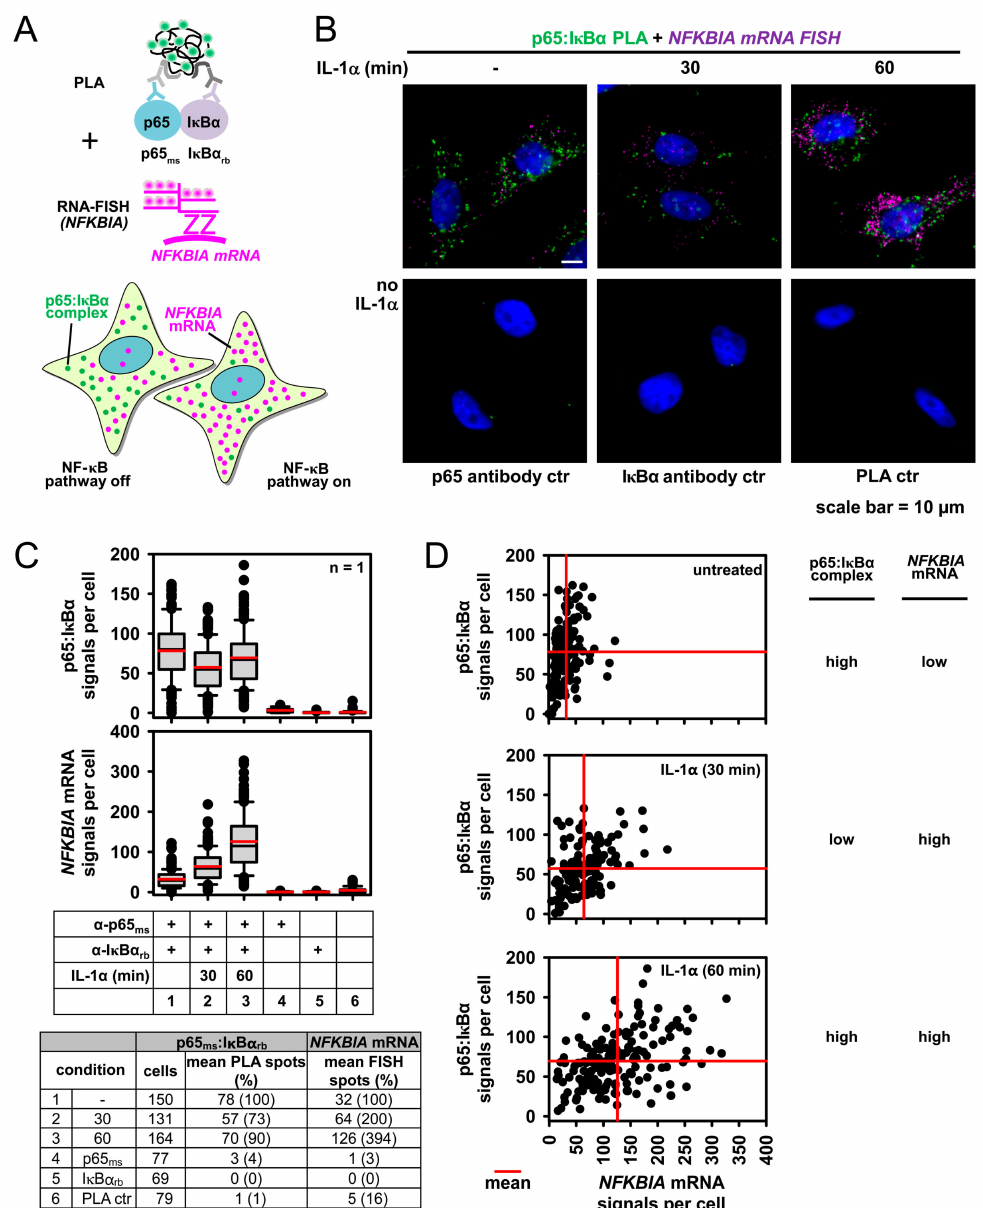
Figure 6. PLA combined with RNA-FISH of the IL-1 α target gene NFKBIA to study downstream NF- κ B functions in the nucleus. ( A ) Scheme of the modified PLA procedure coupled to single molecule (sm)RNA-FISH that allows to discriminate p65 / I κ B α complex formation in unresponsive cells compared to (neighbouring) cells with IL-1 α -induced mRNA expression of the NFKBIA gene that encodes the I κ B α protein. ( B ) HeLa cells remained untreated or were stimulated for 30 or 60 min with IL-1 α (10 ng / mL) as shown. Cells were fixed and p65 / I κ B α complexes were revealed by PLA with specific antibodies followed by NFKBIA smRNA-FISH. PLA signals appear in green, NFKBIA FISH signals in pink and nuclei in blue (stained with Hoechst 33342). The cells were analyzed by fluorescence microscopy, representative merged pictures and PLA negative controls (from untreated cells) are shown. ( C ) Both, PLA and smRNA-FISH signals were counted by the Duolink ® ImageTool. The box plots show the distribution of PLA or smRNA-FISH signals. The table summarizes all relevant single cell data. ( D ) For each cell the number of p65 / I κ B α complexes was plotted against the NFKBIA smRNA-FISH signals. Data from untreated and IL-1 α -stimulated conditions are depicted as separate scatter plots, red lines indicate mean